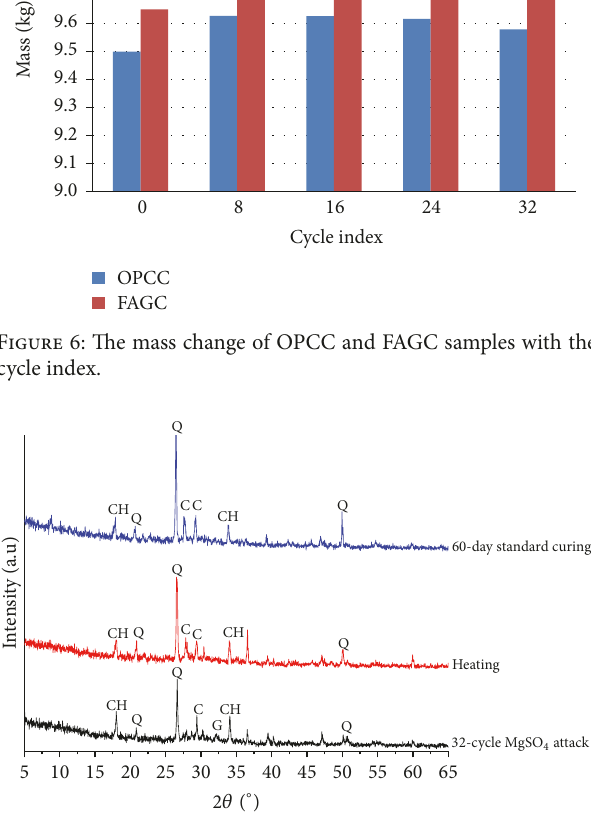
Figure 7: XRD patterns of OPCC in the 60-day standard curing condition, heating condition, and 32-cycle MgSO 4 attack environ- ment, respectively. Q: quartz; CH: calcium hydroxide; G: gypsum; C: C-S-H (calcium silicate hydrate).